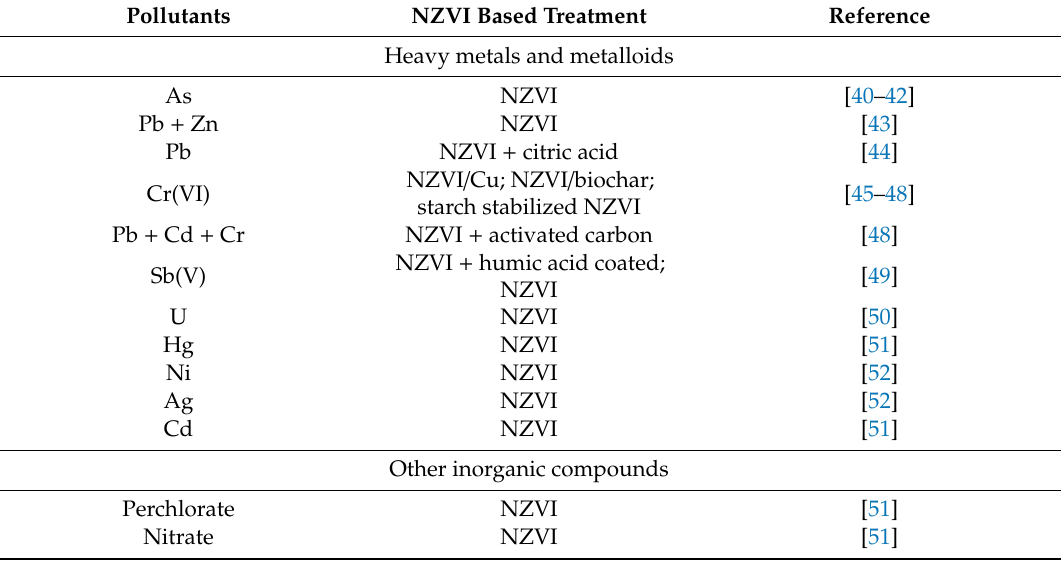
Table 1. Summary of pollutants remediated by zero-valent iron nanoparticles